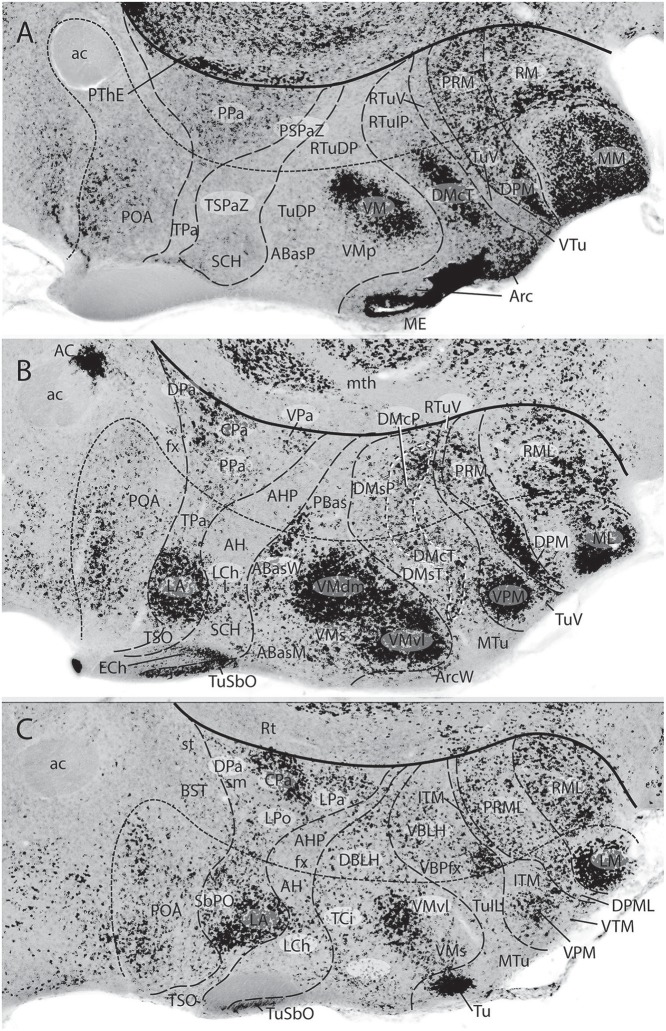
Three sagittal sections through the adult mouse hypothalamus, shown in medio-lateral sequence (A–C), which were in situ reacted for Glu2, a gene marker of glutamatergic excitatory neurons (from Puelles L. et al., 2012a; no copyright permission required). The thick black line indicates the hypothalamo-diencephalic boundary (dorsal to the left; caudal to the top). The nearly parallel line with minute dashes is the intrahypothalamic segmental boundary that separates PHy from THy (or hp1 from hp2). Orthogonal dash lines separate alar and basal longitudinal progenitor domains. The images immediately make clear that the abundance of glutamatergic neurons is substantially higher at THy than at PHy A–C; this is part of the evidence why these domains are considered different prosomeres; some columnar authors described similar compartments as “dorsal and ventral” hypothalamus regions, whereas some other columnar authors identified them as dorsoventrally related subthalamus and hypothalamus columns (the PHy contains the subthalamic nucleus in sections lateral to C). Within the paraventricular alar area, numerous excitatory neurons appear aggregated at the lateral anterior nucleus (LA) within THy (B,C); there is also a dense patch selectively at the CPa subnucleus in PHy (C). The subparaventricular area is largely devoid of this cell type (SCH, AH, AHP). The massive bipartite glutamatergic population within the VM hypothalamic complex (A–C) contrasts with the overall scarcity found at the neighboring DM formation, excepting the latter's periventricular positive core population seen in (A) (probably migrated; DMcT, DMcP). The ventral and dorsal premamillary populations (VPM, DPM) also are largely excitatory (A,B), as are the mamillary and retromamillary formations (MM, LM, RM, RML; A–C). Note the subpallium found dorsal to the hypothalamus (e.g., POA) is generally poor in glutamatergic neurons, as is the reticular prethalamus (Rt; B,C). In contrast, the prethalamic eminence only contains glutamatergic neurons (PThE; A).